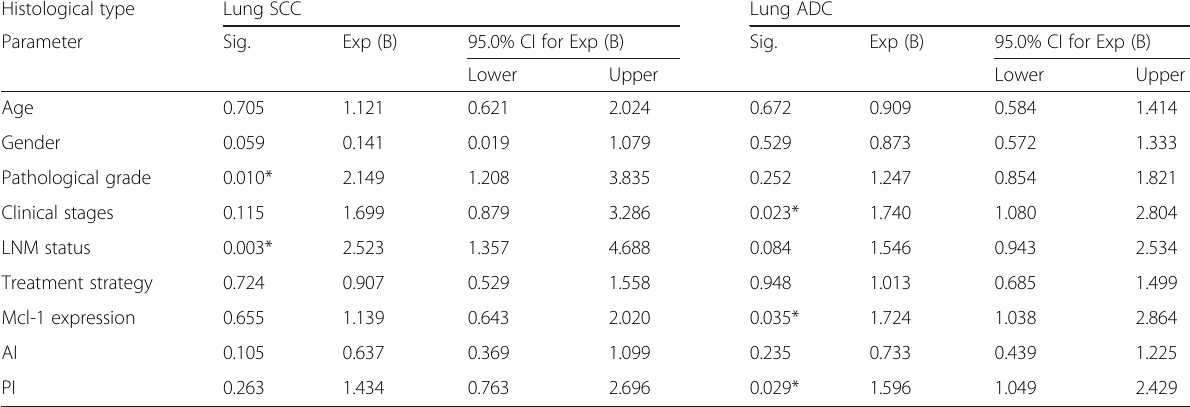
Table 2 Summary of multivariate of Cox proportional regression for overall survival in 350 cases of